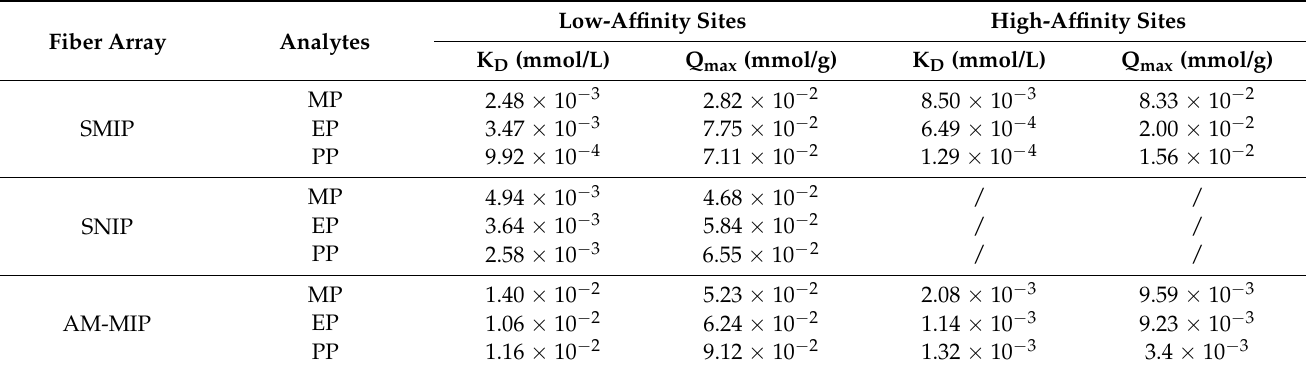
Table 3. Scatchard fitting parameter analysis.